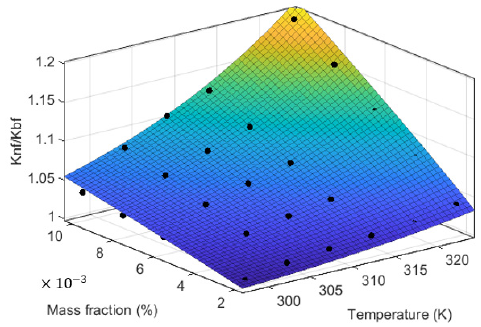
Figure 8. Three-dimension diagram of the proposed correlation.